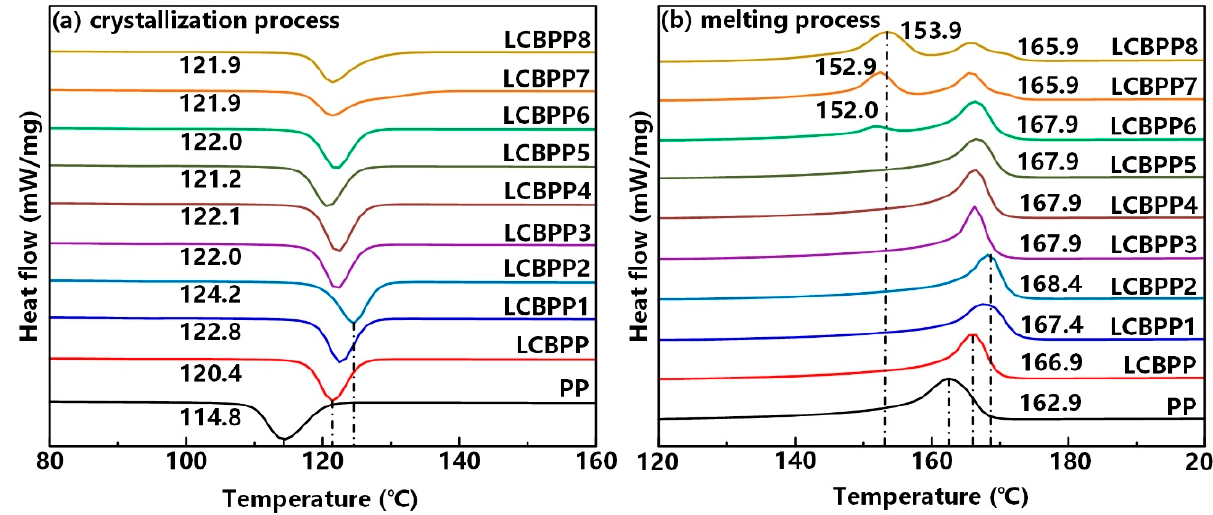
Figure 5. DSC results of the test samples. ( a ) crystallization process, ( b ) melting process. Table 3. Thermal parameters of test samples.